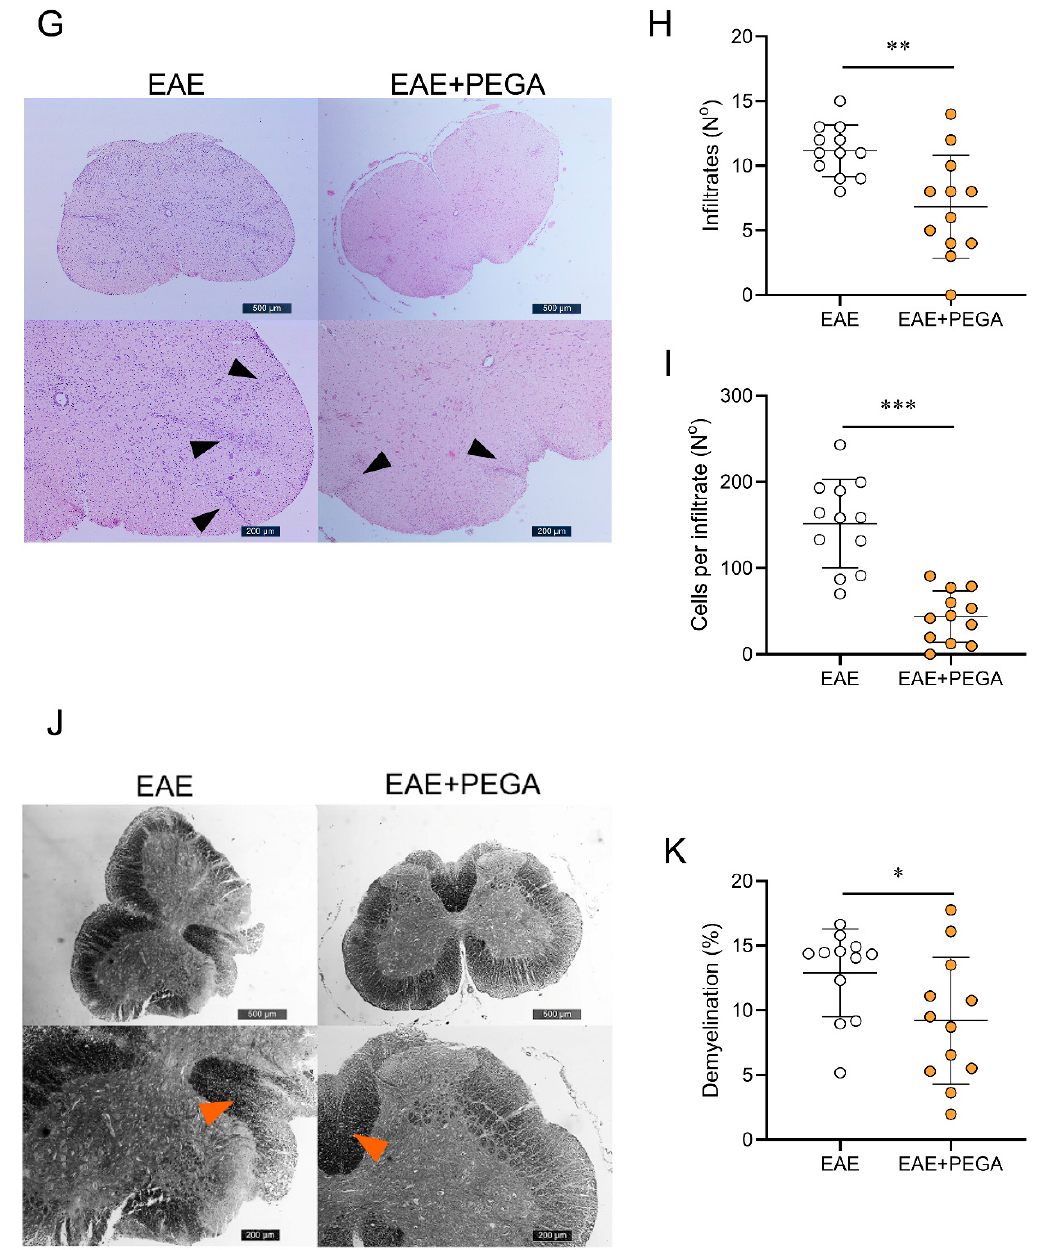
Figure 4. Effects of PEGA on EAE. PEGA or vehicle were administereddaily for 9 days, starting on day 7 p.i. Clinical signs were monitored daily ( A ) in vehicle-treated (EAE) and PEGA-treated (EAE+PEGA) rats. The duration of EAE ( B ), cumulative c.s. ( C ), mean c.s. ( D ), maximal c.s. ( E ), and day of onset ( F ) were calculated (n = 11 rats per group). Spinal cord sections from PEGA-treated or untreated rats were obtained at the peak of clinical signs in the EAE group and stained with H&E ( G , representative micrographs, scale bar–500 µ m, infiltrates are indicated by the arrows). The number of infiltrates per spinal cord section ( H ), and the number of cells per infiltrate ( I ) were determined on H&E-stained sections (three rats per group, four sections per rat). Demyelinated areas were visualized by Sudan black staining ( J , representative micrographs, scale bar—500 μ m) and quantified by ICY (three rats per group, four sections per rat) ( K ). Data are presented as mean +/ − SD. Student’s t -test, * p < 0.05, ** p < 0.01, *** p < 0.001, EAE vs. EAE + PEGA.